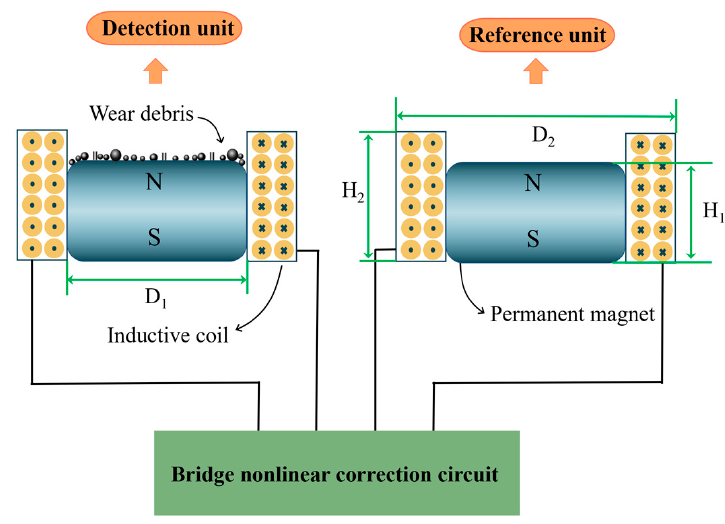
Figure 1. Structure diagram of magnetic plug